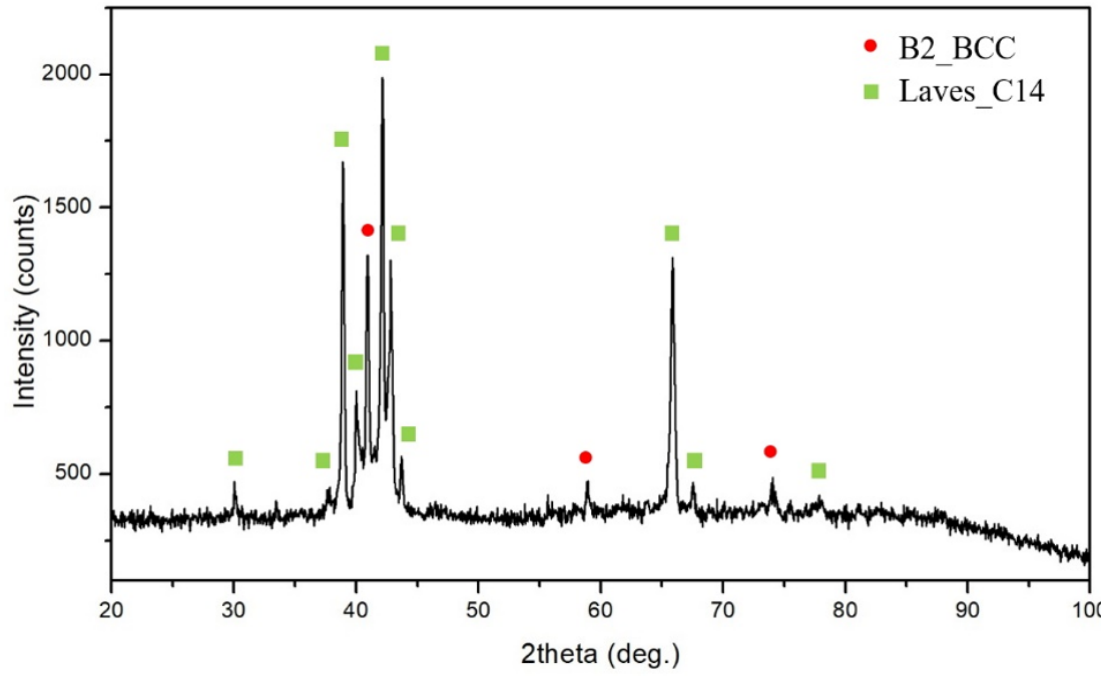
Figure 2. XRD pattern of the CuFeTiZrNi 0.1 alloy.